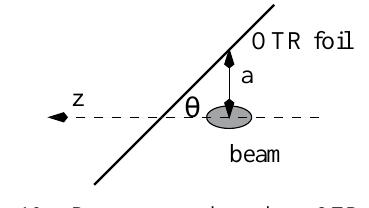
FIG. 10. Beam passes through an OTR screen